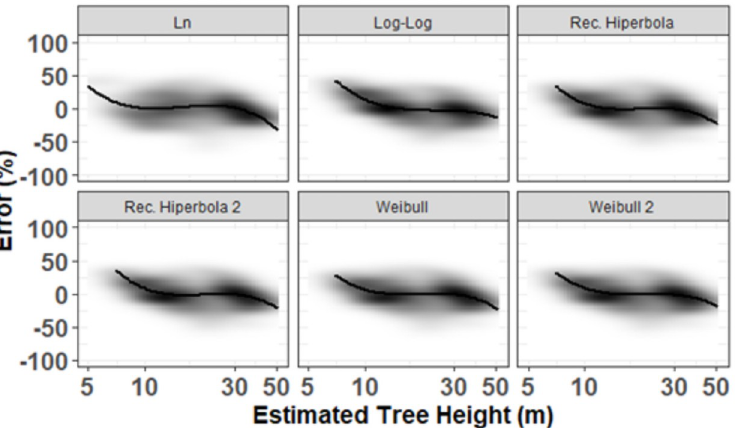
Fig 3. Percentage error (estimated Ht minus observed Ht, divided by the observed Ht, in%) vs estimated height values for the six non-linear theoretical models; the thick black line represents a spline regression of the data points, illustrating a slight negative bias at large estimated height values (values > 30 m). The background represents the density of the data point (n = 126 trees).